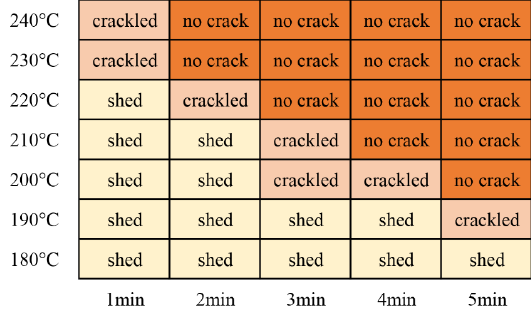
Figure 13. Impact resistance test results for the coatings.